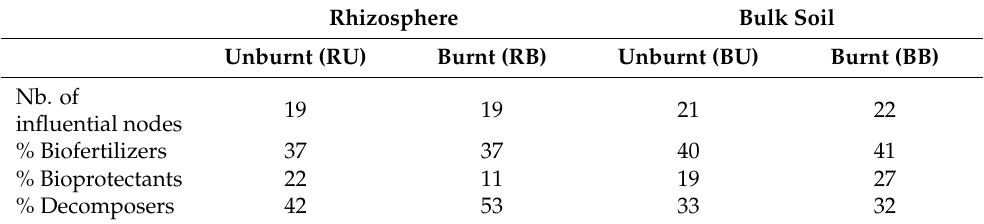
Table 3. Classification of bacterial taxa to putative functional